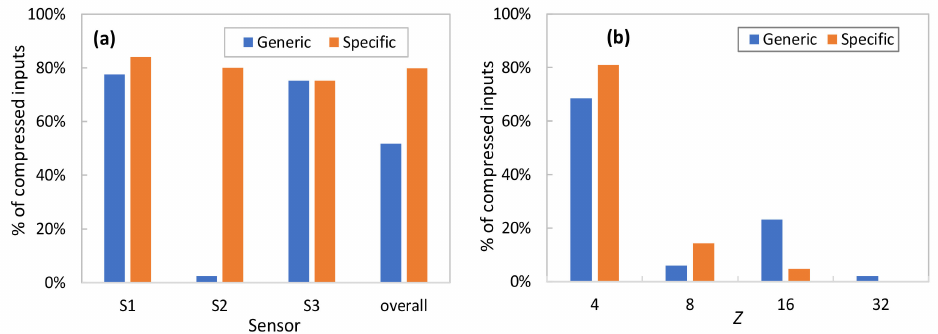
Figure 7. Generic and specific AAC performance vs. sensor type ( a ) and latent space size ( b